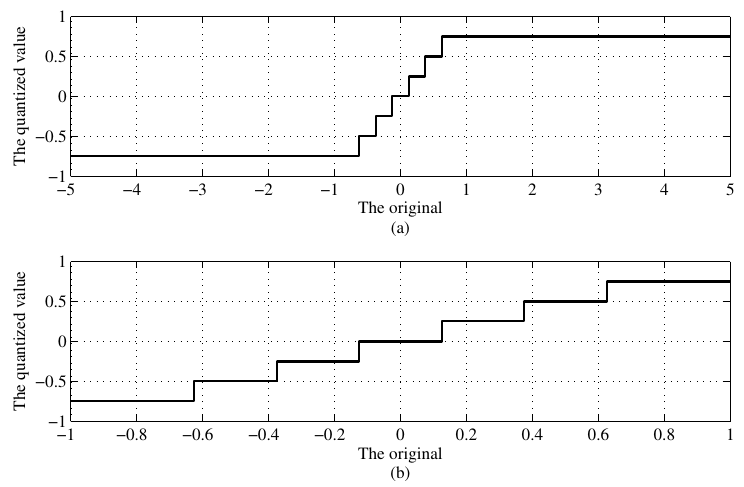
Figure 3. ( a ) The linear quantization without normalization. ( b ) The linear quantization with local